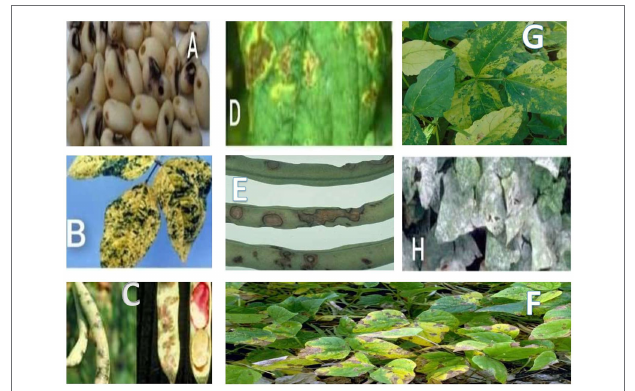
FIGURE 1 | Microbial diseases of cowpea: (A) cowpea seed beetle, (B) yellow mosaic virus infected cowpea, (C) cowpea halo blight, (D) bacterial blight, (E) anthracnose, (F) cowpea mosaic diseased leaf, (G) bacterial bean blight, and (H) powdery